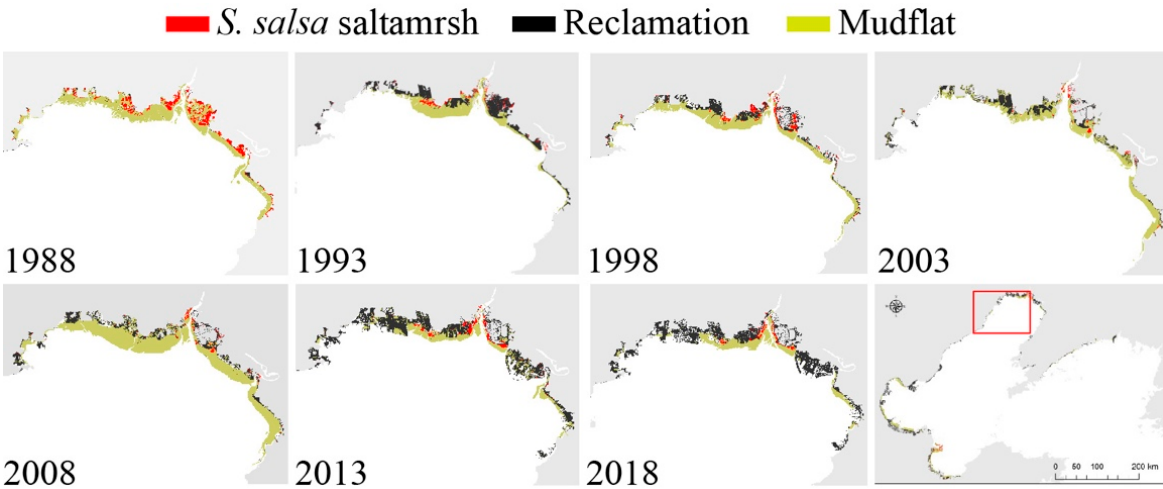
Figure 4. Maps showing the land cover change of the S. salsa saltmarsh area and mudflats and the reclaimed land along the NYSC between 1988 and 2018.